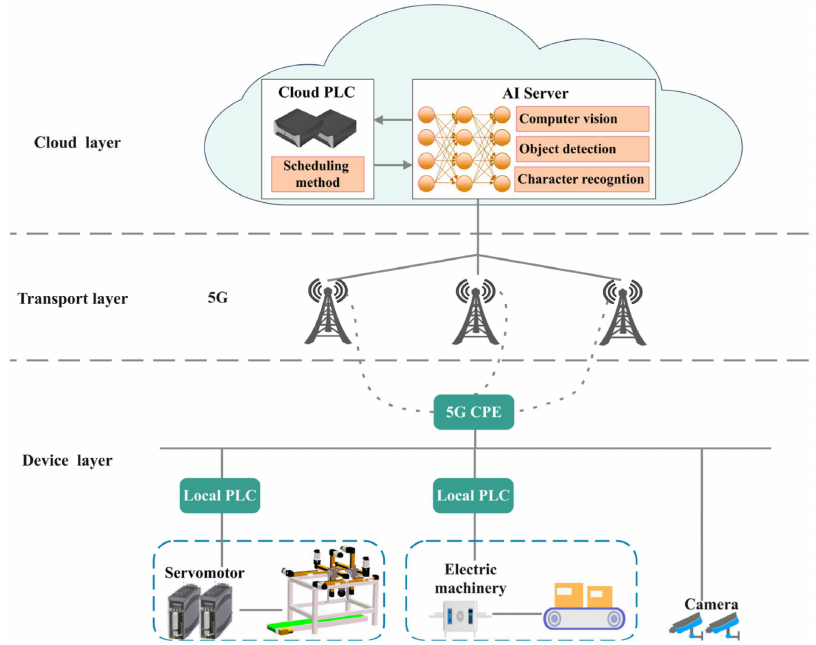
Figure 1. The architecture of multi-crane visual sorting